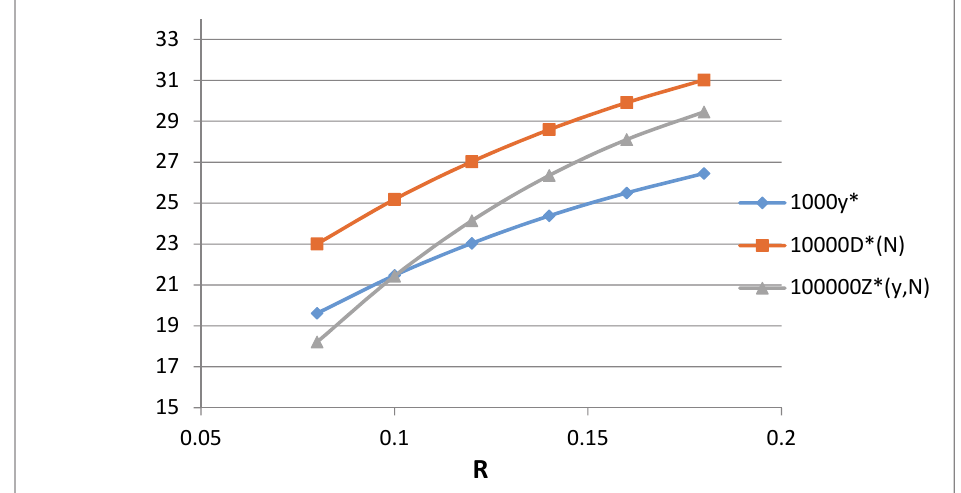
Fig. 11. Behaviour of optimal values of on y*, E[ Z* ( y,N )] , D* ( N ) with increase in R